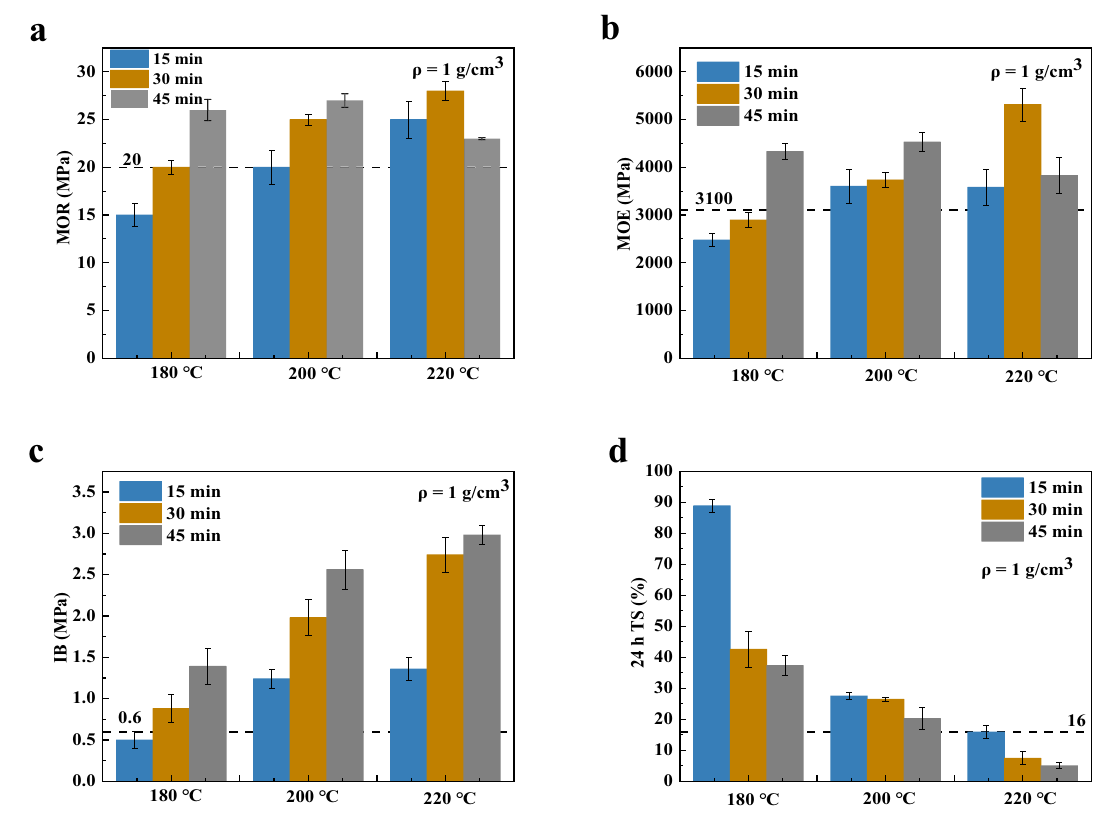
Fig. 6 Effects of pressing temperature and pressing time on physical and mechanical properties of binderless board. a Effects of pressing temperature and time on the MOR of binderless board. b Effects of pressing temperature and time on the MOE of binderless board. c Effects of pressing temperature and time on the IB of binderless board. d Effects of pressing temperature and time on 24 h TS of binderless board. Error bars indicate standard deviations